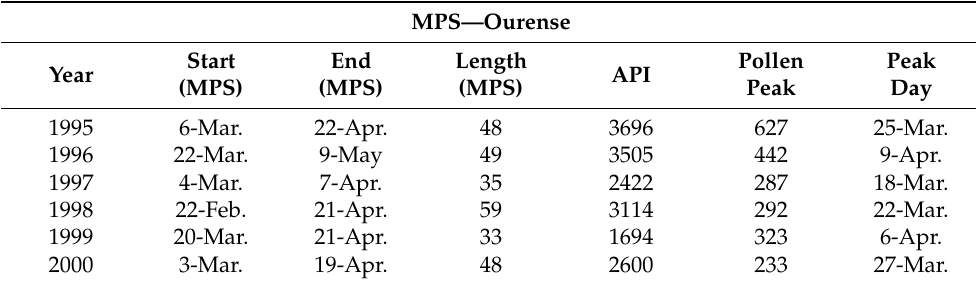
Table 2. Pinus MPS during the 25 study years in the transition Eurosiberian (Orense): start date, end date, length, API (pollen grains), daily pollen peak (pollen grains/m 3 ) and peak date. Average, mini- mum and maximum values, standard deviation (SD) and relative standard variation in percentage (%RSD) are included. The logistic method was